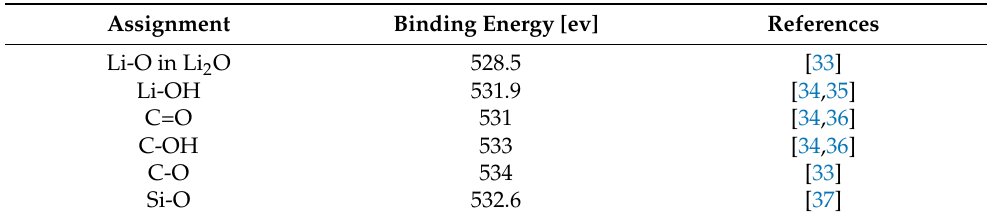
Table 2. Chemical groups and their respective energies in the O 1s signal. The references are also